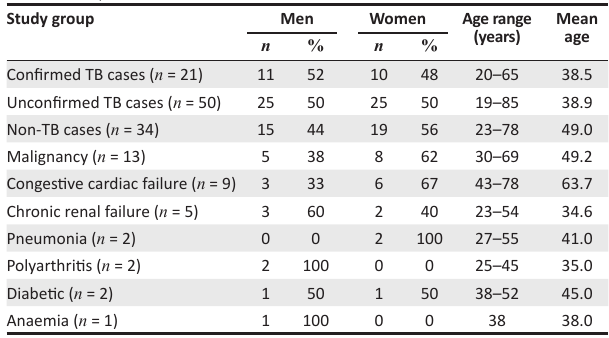
TABLE 1: Demographic characteristics of cases included in the study, Pretoria, South Africa, 2008-2009. Study